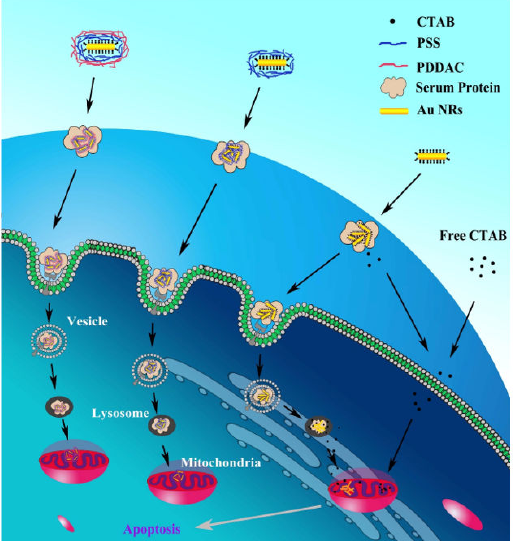
Figure 21. The mechanism for cytotoxicity and GNR uptake [137]. Reprinted with permission from ref. [137]. Copyright 2010